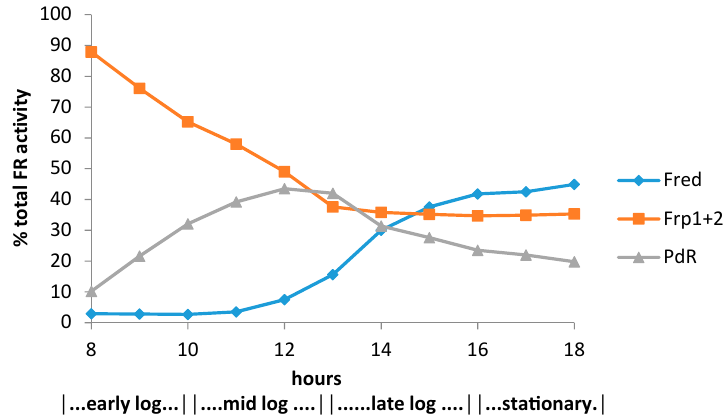
Figure 7. Relative contribution of the different assayed FNR-generating enzymes to the total flavin reductase activity titre throughout the various phases of ( rac )-camphor-dependent growth of P. putida ATCC 17543 [18].